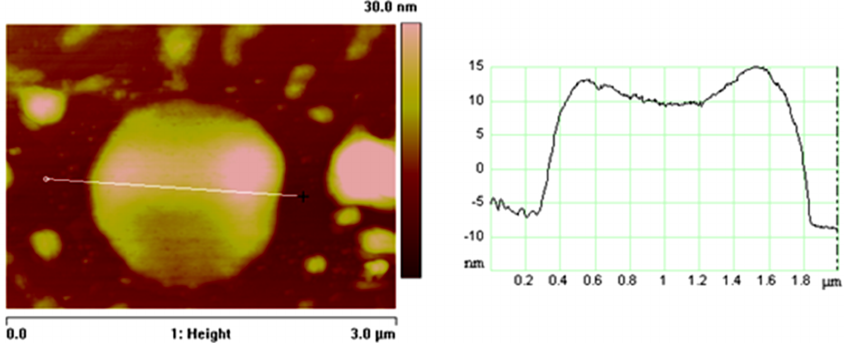
Figure 7. Large marine vesicle of 1.5µm diameter imaged by AFM with the corresponding cross section along the indicated line. Samples were collected in the northern Adriatic (SJ 101) in 18 May 2010, at a depth of 0m.